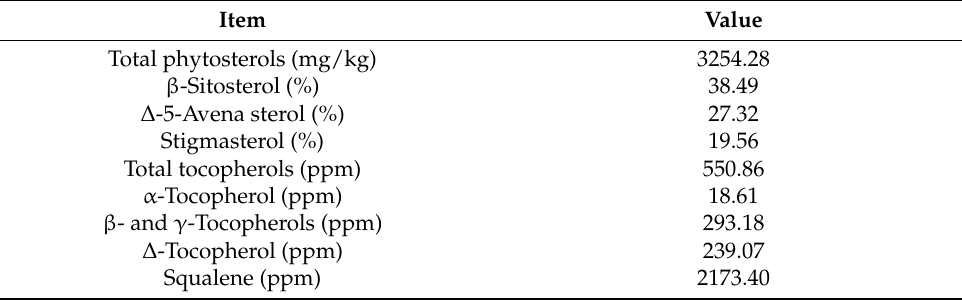
Table 3. Bioactive phytochemical compounds of raw amaranth